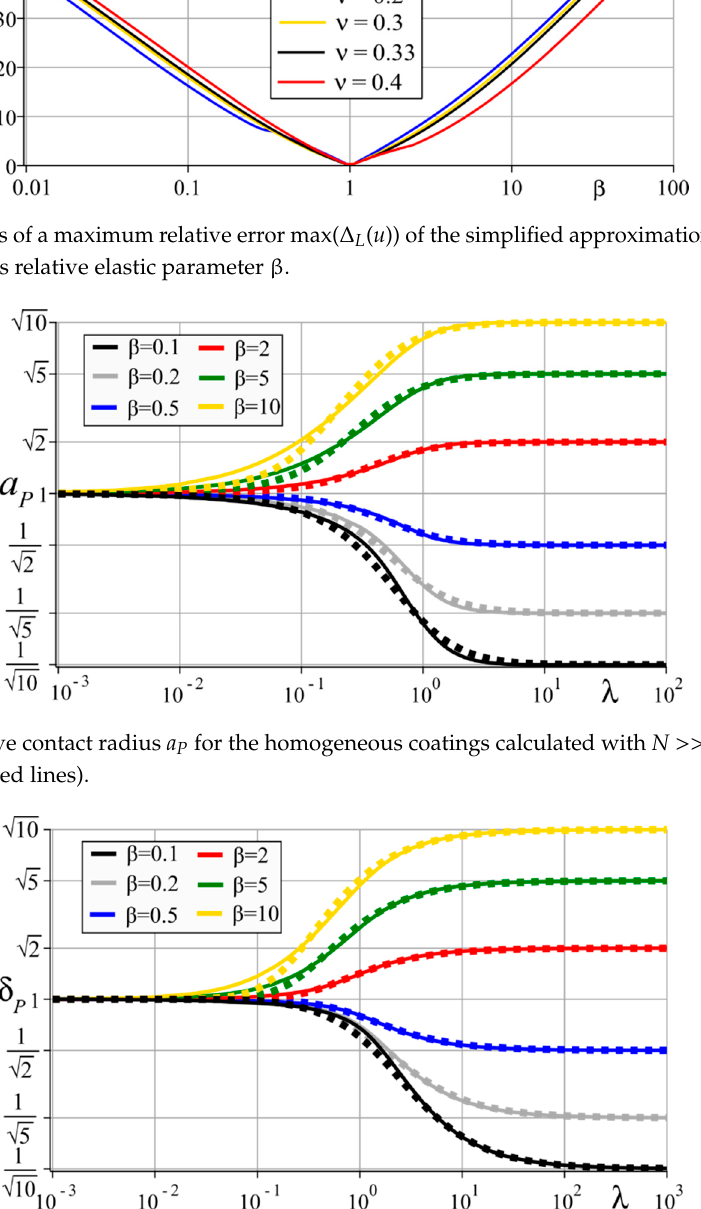
Figure 6. Relative indentation stiffness S P for the homogeneous coatings calculated with N >>1 (solid line) and N = 1 (dashed line). As an example of the relative error distribution, the dependence of Δ (cid:3028) on parameter λ for β = 0.5 is presented on the Figure 7. All other characteristics Δ (cid:4668)(cid:3028),(cid:3020),(cid:3083)(cid:4669) for any β look pretty similar. They look like three hills standing together. These hills correspond to three ranges of values of λ : (−∞, λ (cid:2868) ), (λ (cid:2868) , λ (cid:2869) ), (λ (cid:2869) , ∞) . The values of λ 0 and λ 1 (different for Δ (cid:3028) , Δ (cid:3020) and Δ (cid:3083) ) were obtained to satisfy: Δ (cid:4668)(cid:3028),(cid:3020),(cid:3083)(cid:4669) (λ (cid:2868) ) = Δ (cid:4668)(cid:3028),(cid:3020),(cid:3083)(cid:4669) (λ (cid:2869) ) = 0 . Tables 1–3 contain the values of λ 0 , λ 1 and maximum values of Δ (cid:4668)(cid:3028),(cid:3020),(cid:3083)(cid:4669) in these three ranges. Tables show that the error of the simplified expressions for S P , a P , δ P is 2–4 times lower than the error of the one-parametric approximation of the kernel transform by the expression in Equation (19). It is also seen, that the maximum error observed in a single region can be much smaller than the total maximum error. Figure 7. Graph of the relative error Δ a of a simplified expression a P versus relative coating thickness λ for β = 0.5.